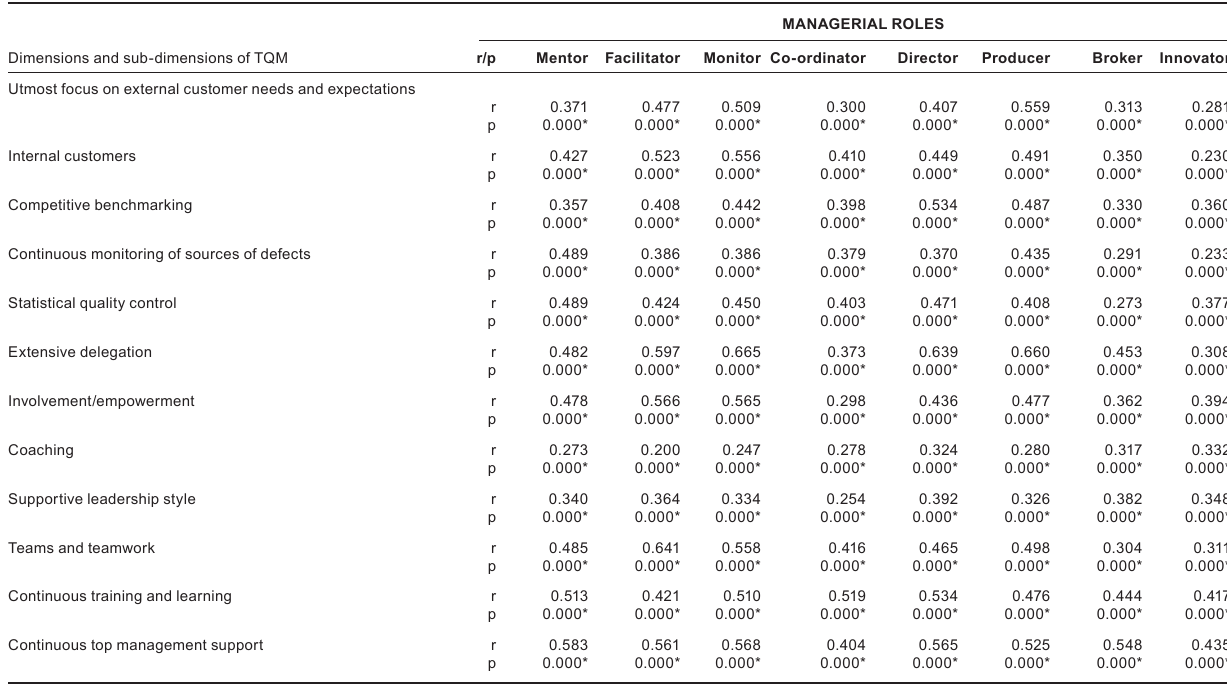
Table 5 Intercorrelations : Dimensions and sub-dimensions of TQM and managerial roles determining management effectiveness